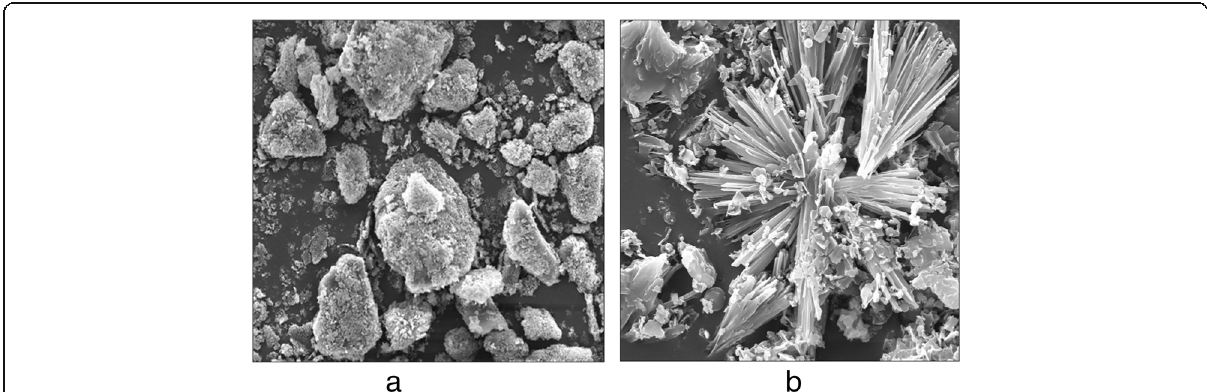
Fig. 9 SEM Images of the a Lercanidipine and b Lercanidipine nanocrystals